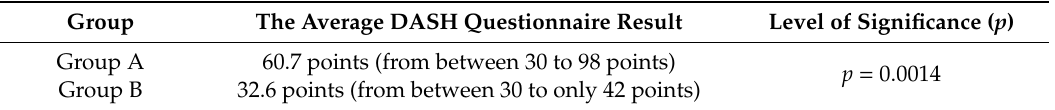
Table 1. DASH (The Disabilities of the Arm, Shoulder and Hand) questionnaire results.